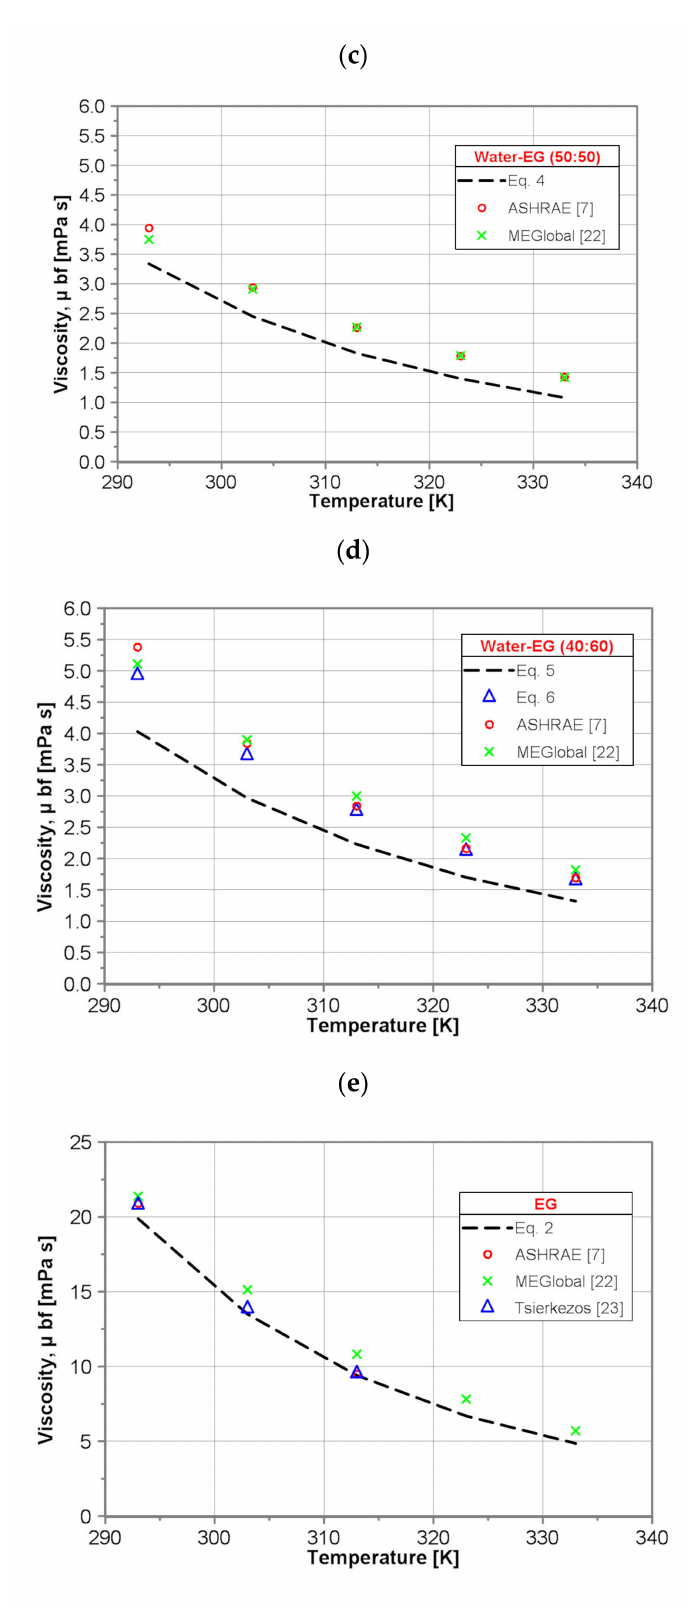
Figure 1. Comparison of the base fluids dynamic viscosity; ( a ) water, ( b ) water / EG(60:40), ( c ) water / EG(50:50), ( d ) water / EG(40:60) and ( e )